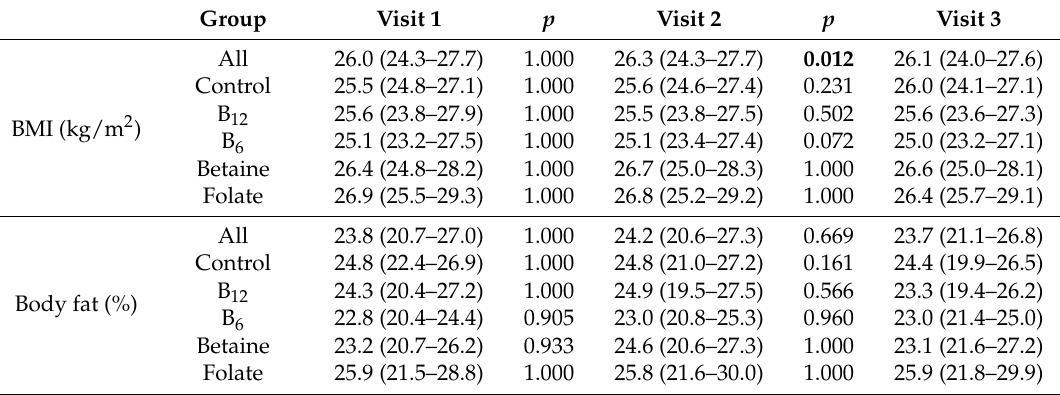
Table 1. Basic characteristics of the study population. BP, blood pressure; eGFR, estimated glomerular filtration rate using the CKD-EPI 2009 creatinine formula [33]. The baseline characteristics were not significantly different between the experimental